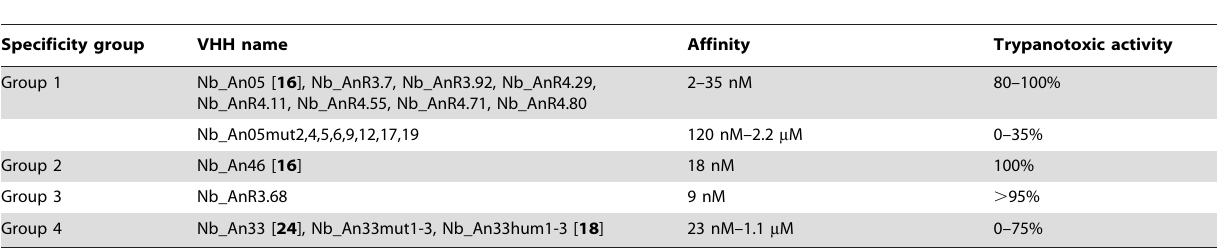
Table 2. Characterization of the available panel of trypanotoxic Nanobodies.